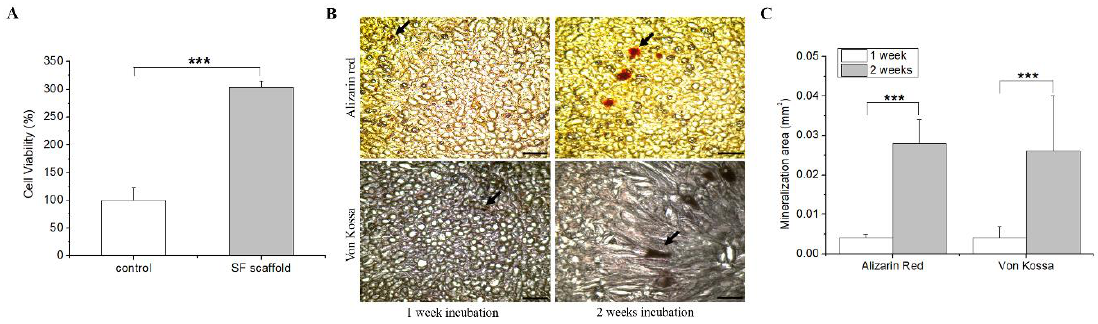
Figure 3. In vitro biocompatibility and osteogenic differentiation of hASCs seeded on the SF scaffold. ( A ) Cell viability analysis of SF scaffold; ( B ) Alizarin red and Von Kossa staining of the cryosection slices of SF-hASCs scaffolds (black arrow = mineral deposition; scale bar = 500 μm); ( C ) quantitative determination of mineralization area in the SF-hASCs scaffolds (***, p ≤ 0.001).